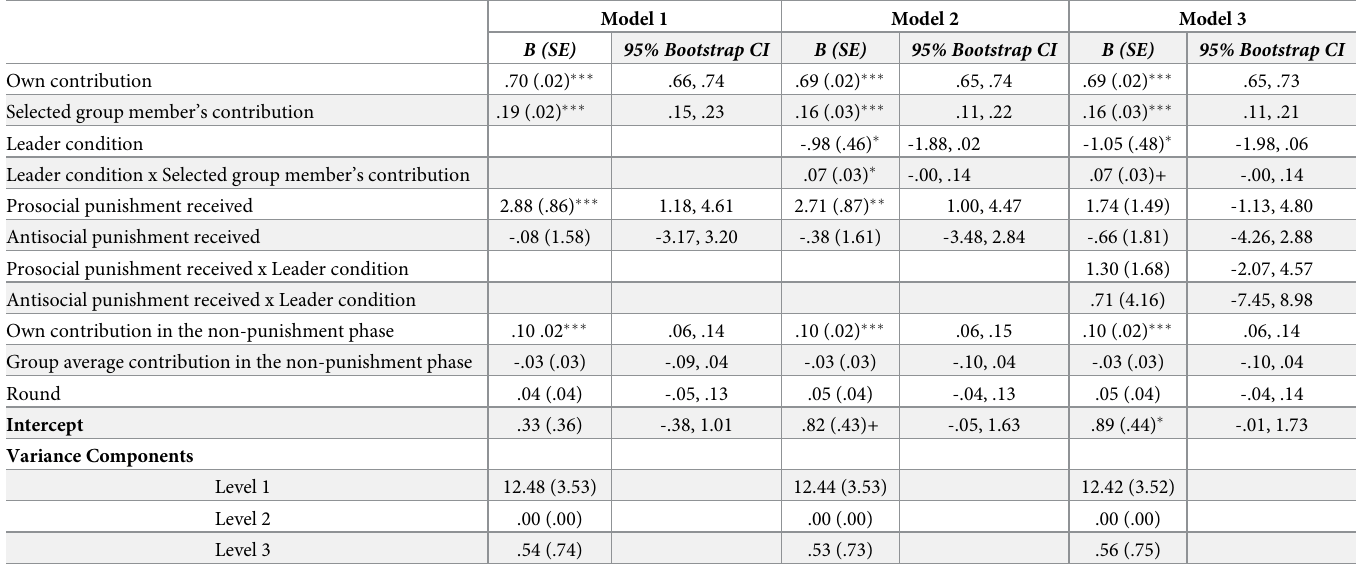
Table 2. Leaders’ cooperation is more influential in promoting group members’ cooperation in the next round, compared to peers’ behaviors in peer punishment